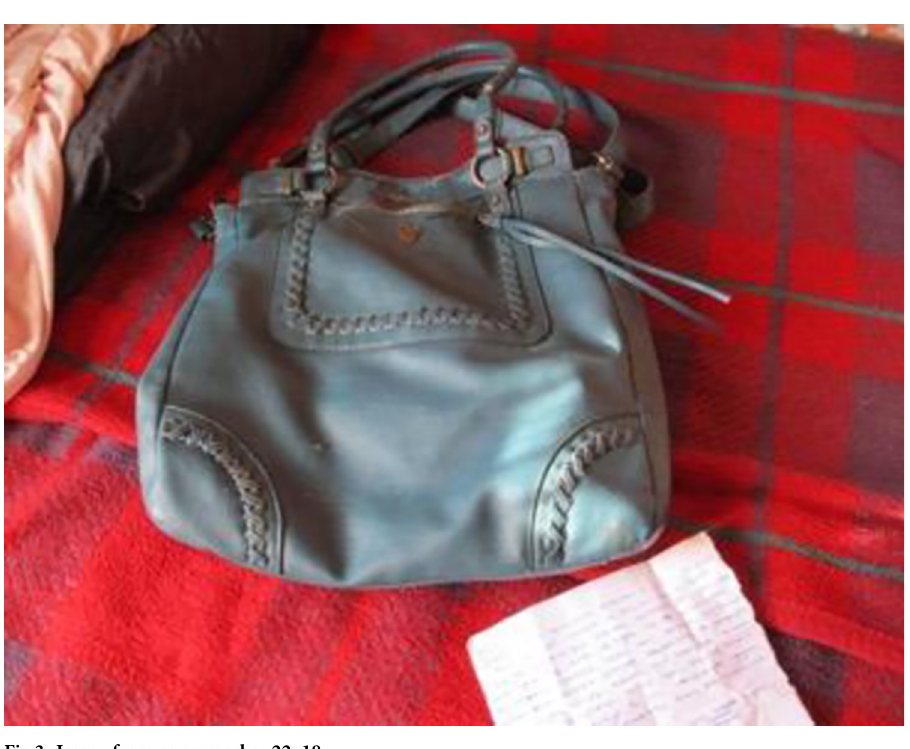
Fig 3. Image from co researcher